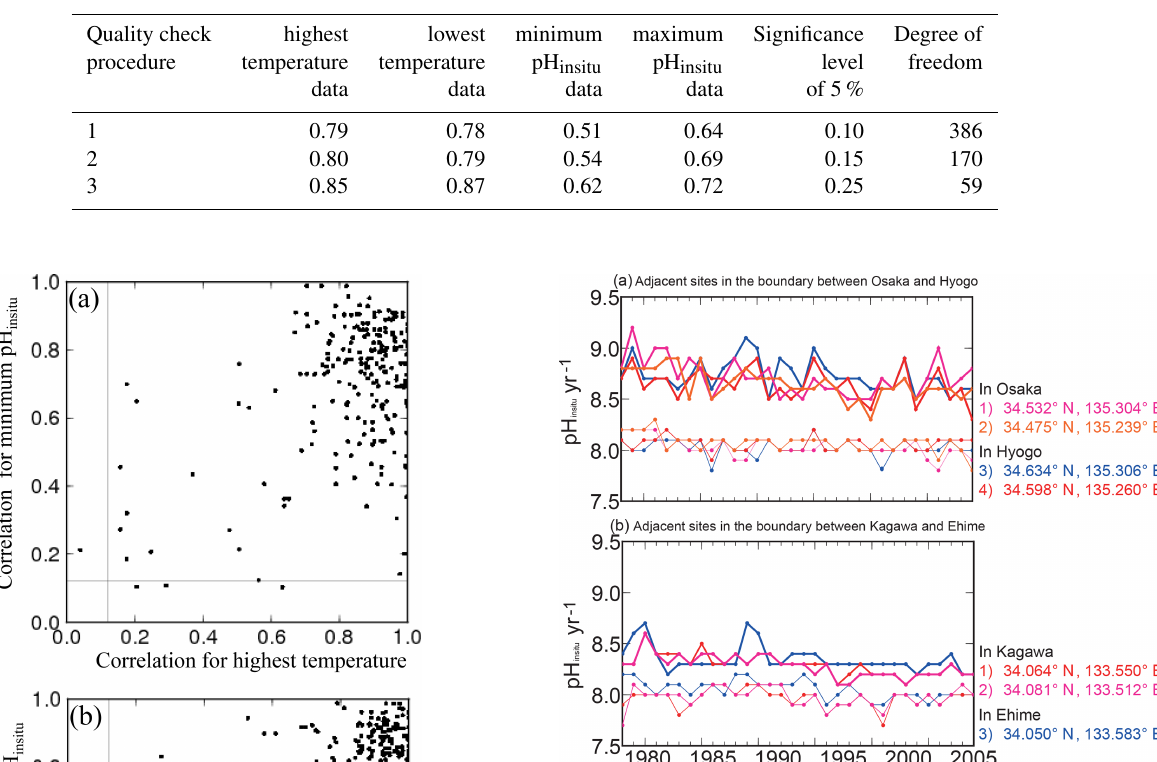
Table 2. Average mutual correlation coefficients among water temperature and pH insitu measurements at adjacent monitoring sites in the same prefecture. The averages were calculated from the data for the highest and lowest temperature, and minimum and maximum pH insitu within 15km for the three criteria. We refined the sites using three quality control steps, yielding 1481 (step 1), 1127 (step 2), and 302 (step 3) sites. The two rightmost columns represent a significant level of 5% and a degree of freedom for the correlation coefficients of each quality check procedure.